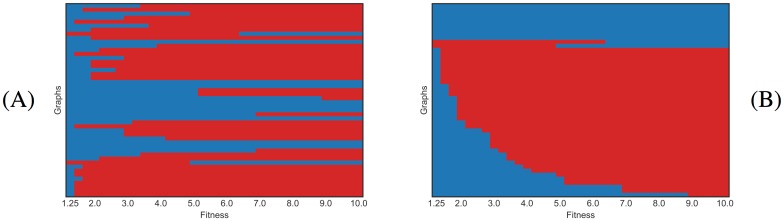
Barcodes describing regime transition of graphs of order 7.Each horizontal line corresponds to a graph, and color represents the evolutionary regime for the given fitness: blue color corresponds to the suppression regime and red color to the amplification regime. (A) Unsorted data for suppressors and graphs with one transition. (B) Sorted data for suppressors and graphs with one transition.